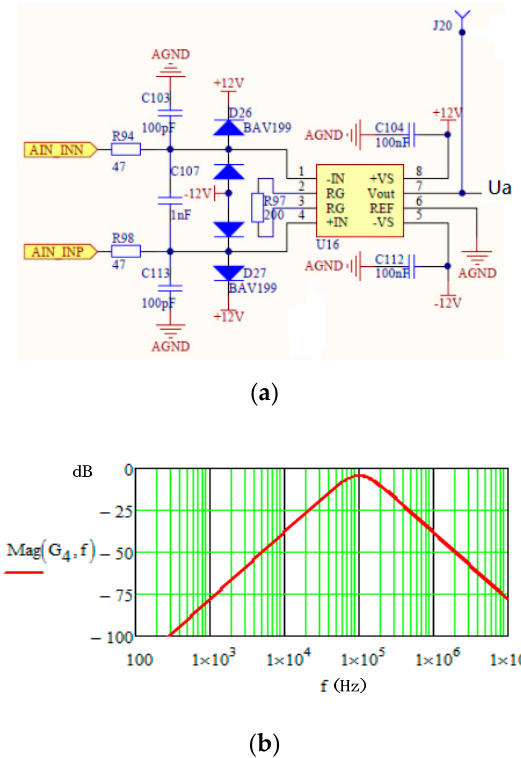
Figure 8. Front-stage differential amplification filter circuit. (a) Differential amplifier circuit. ( b ) Bode diagram of filter transfer function.